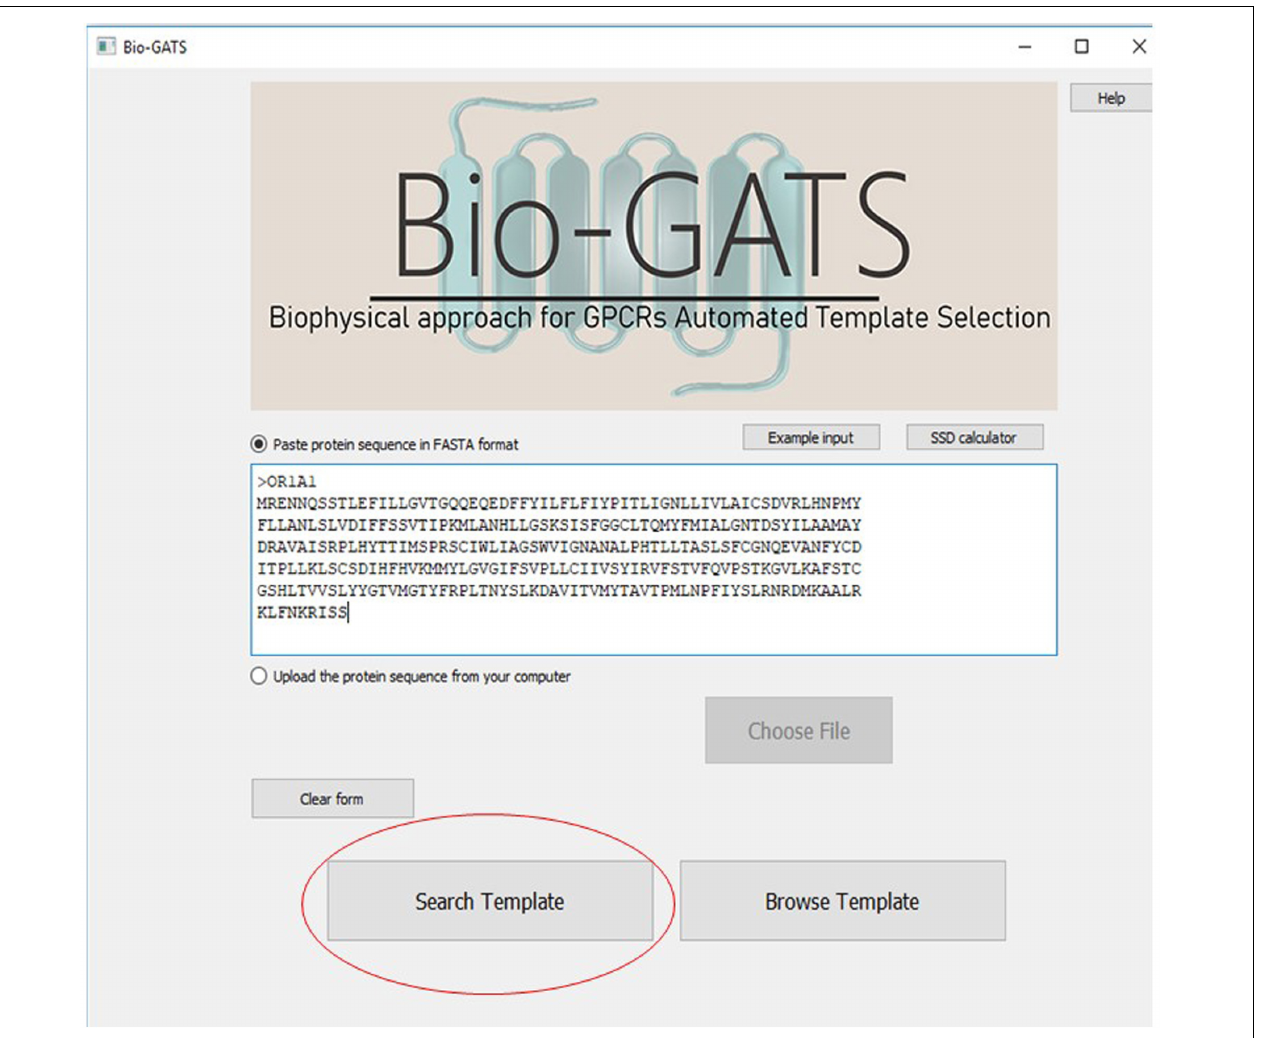
FIGURE 6 | The main interface of Bio-GATS. Automated selection of templates can be done by clicking on the search template button.